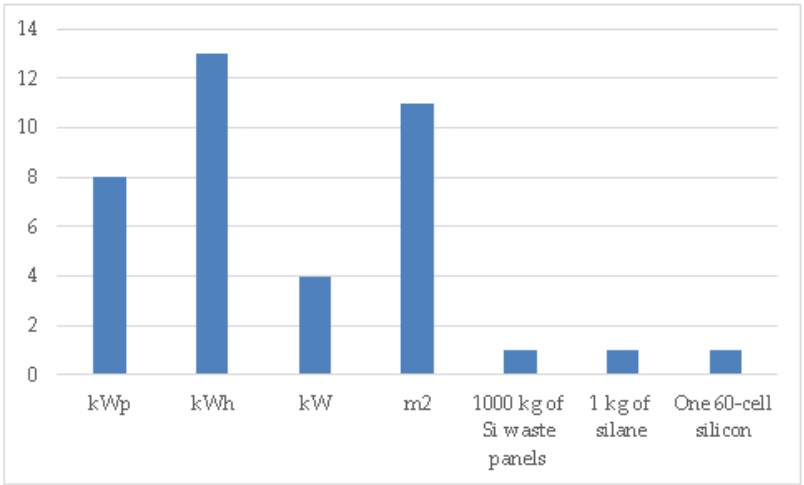
Figure 4. Number of works that used the same FU.